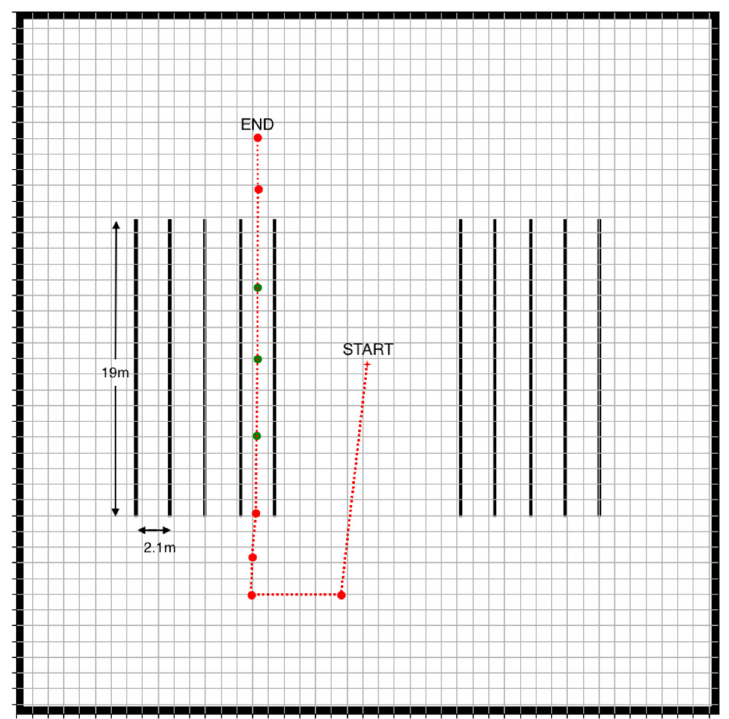
Figure 9. The test robot path used in the experiments. The red dots are the selected waypoints, and the red line indicates the desired robot path. The green dots are work waypoints where the robots must stop and harvest. The red cross indicates the initial position of a robot.